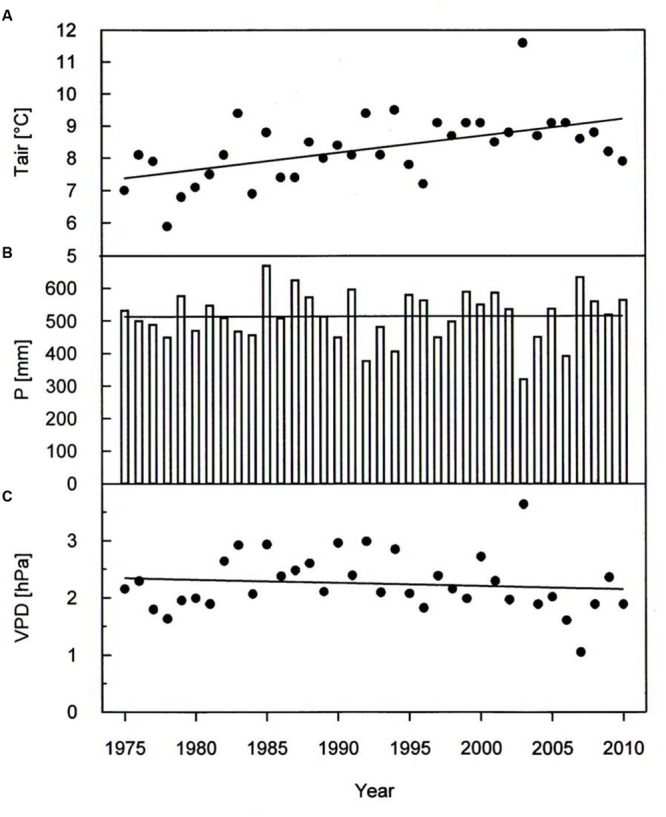
Temporal variation in (A) growing season mean air temperature (Tair), (B) total growing season precipitation (P) and (C) growing season mean vapor pressure deficit (VPD) during the period 1975 throughout 2010. Data were fit by linear regression analysis: Tair: y = 0.053x-97.0, r2= 0.30, P < 0.001; P: y = 0.075x-365.3, r2= 0.00, P = 0.95; VPD: y = -0.055x + 13.3, r2= 0.01, P = 0.49.